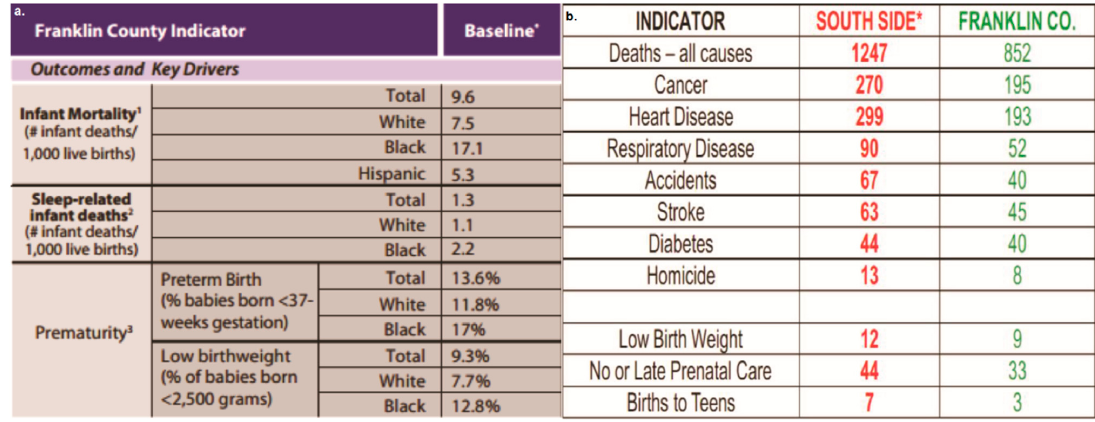
Figure 1. ( a ) Franklin County (Franklin CO.) infant birth outcomes [36]. ( b ) Comparison between South Side health statistics and Franklin County (birth and prenatal care numbers noted in percentages) [3,45–48].